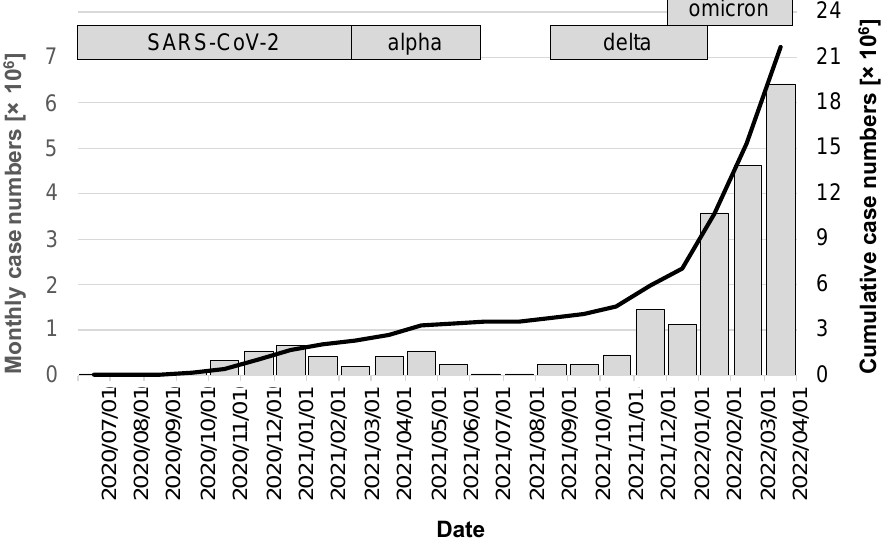
Figure 3. Case numbers in the observation period between release of the CWA and 1 April 2022. The gray bars indicate the cases of the month preceding the day marked on the x-axis and are scaled on the left y-axis. The cumulative case numbers are visualized by the black line with scaling on the right y-axis.